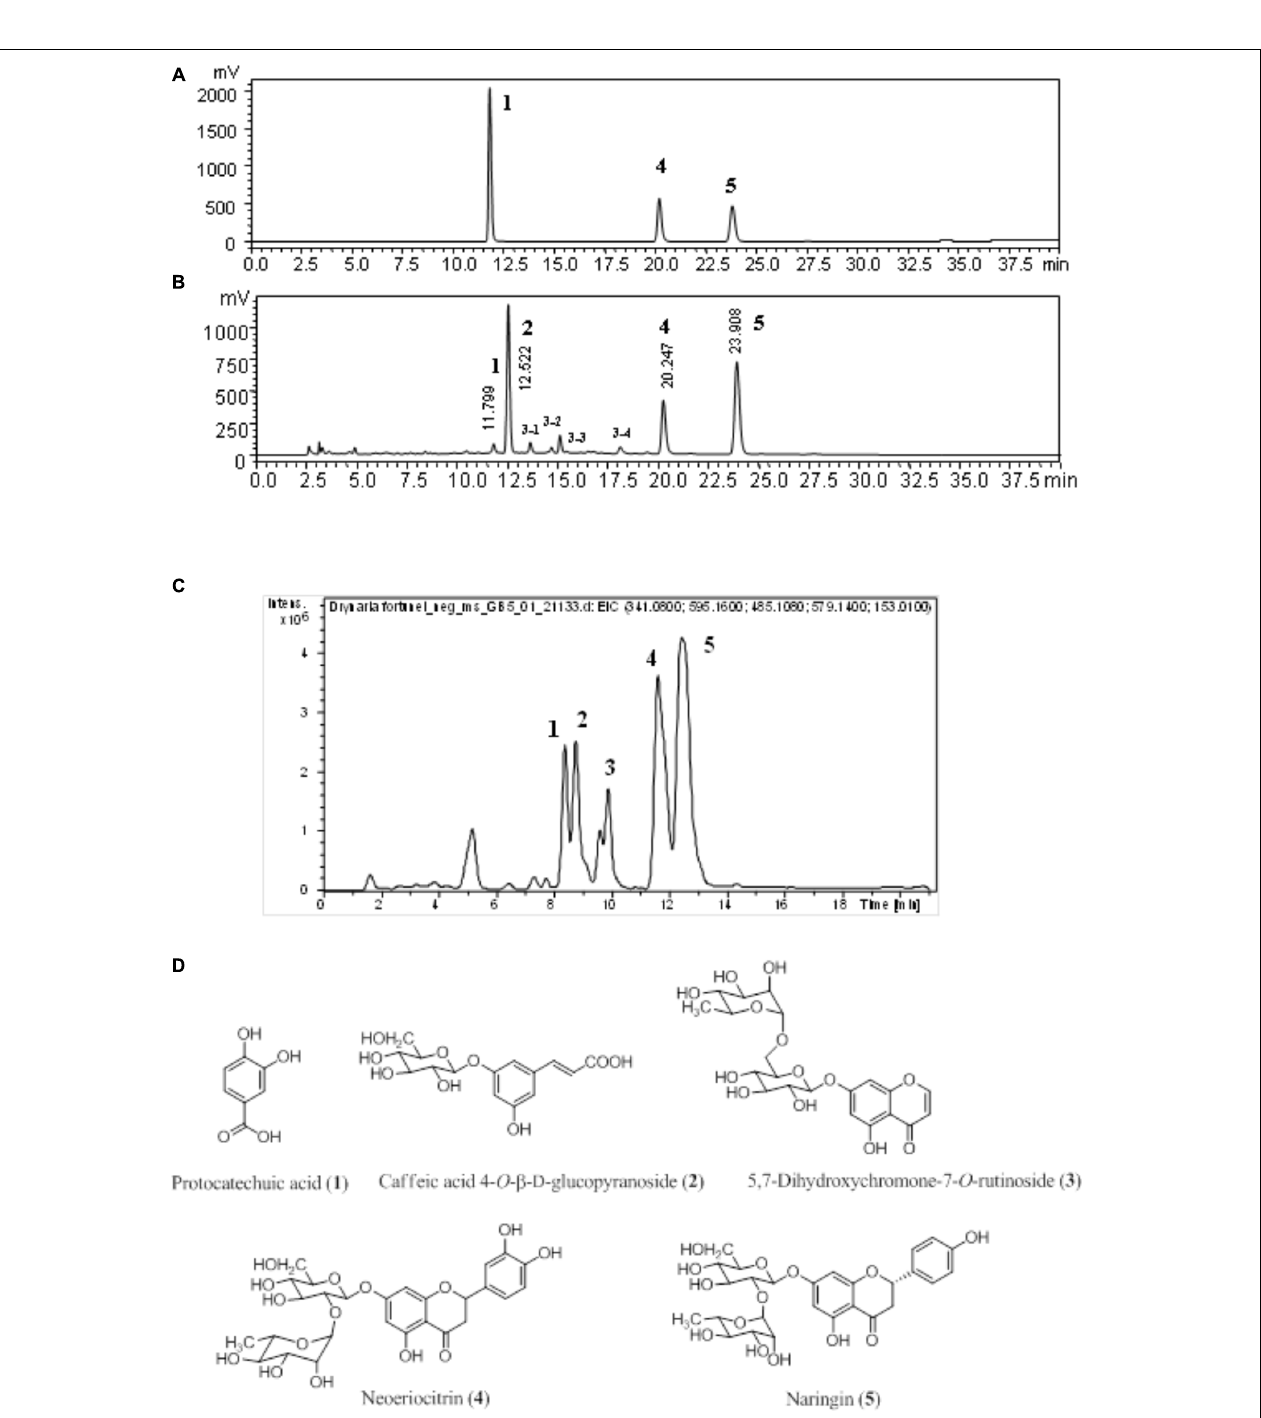
FIGURE 1 | The chromatogram of D. fortunei aqueous extract. The authentic standards (A) and D. fortunei aqueous extract (B) of HPLC and EIC (C) with identification of extract included protocatechuic acid ( 1 ), caffeic acid 4- O - β - D -glucopyranoside ( 2 ), 5,7-dihydroxychromone-7- O -rutinoside (3), neoeriocitrin ( 4 ) and naringin ( 5 ). The structures of 1 - 5 were shown in (D) . The respective gradient program and column of HPLC (A,B) and UPLC (C) , see the section “Chromatographic Procedure.”